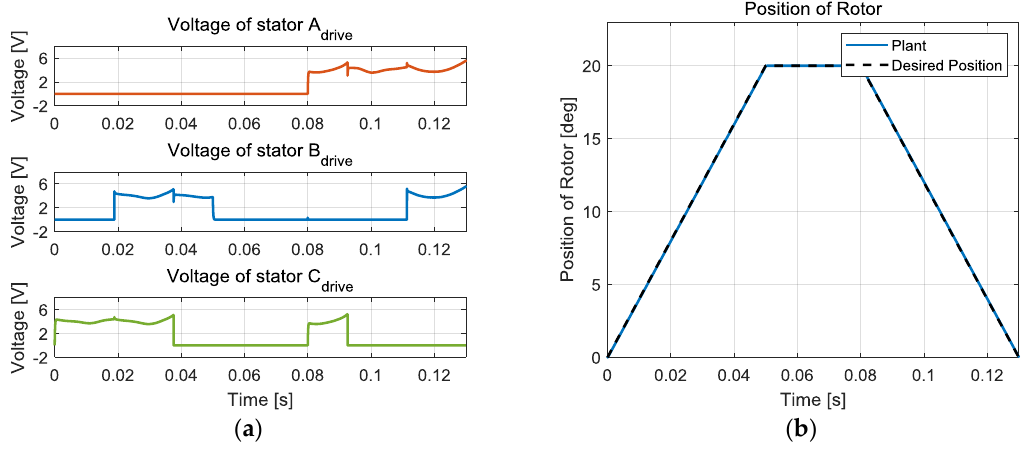
Figure 4. Example of position control operation: ( a ) Input voltage, ( b ) Rotor position.